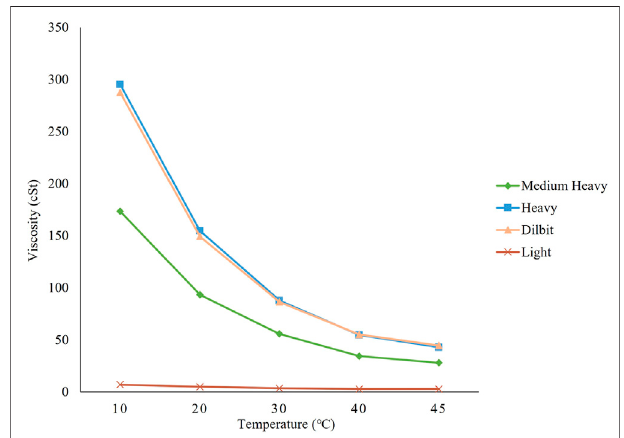
FIGURE 2 | The relationship between temperature and viscosity of conventionalcrudesand dilbit.Adapted fromTsaprailisetal.(2014)(Tsaprailis et al.,